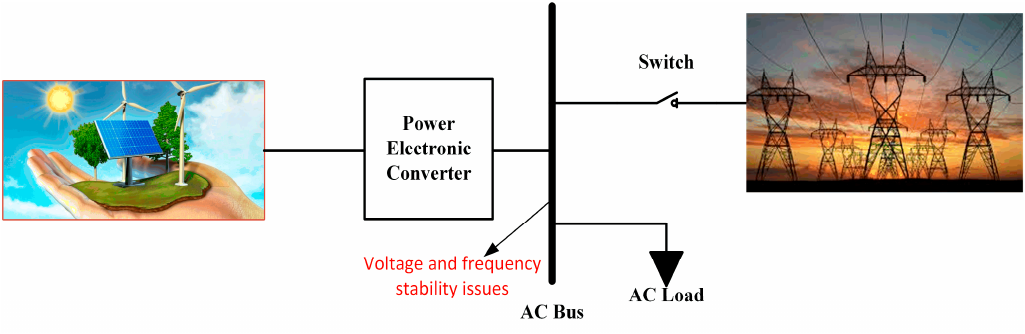
Figure 2. RES integration with grid.